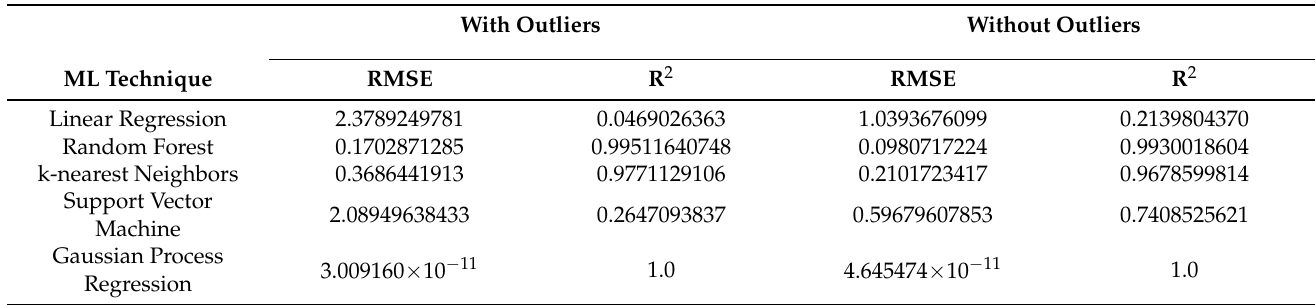
Table 13. PM 1 results for the suspended particulate matter measuring device.